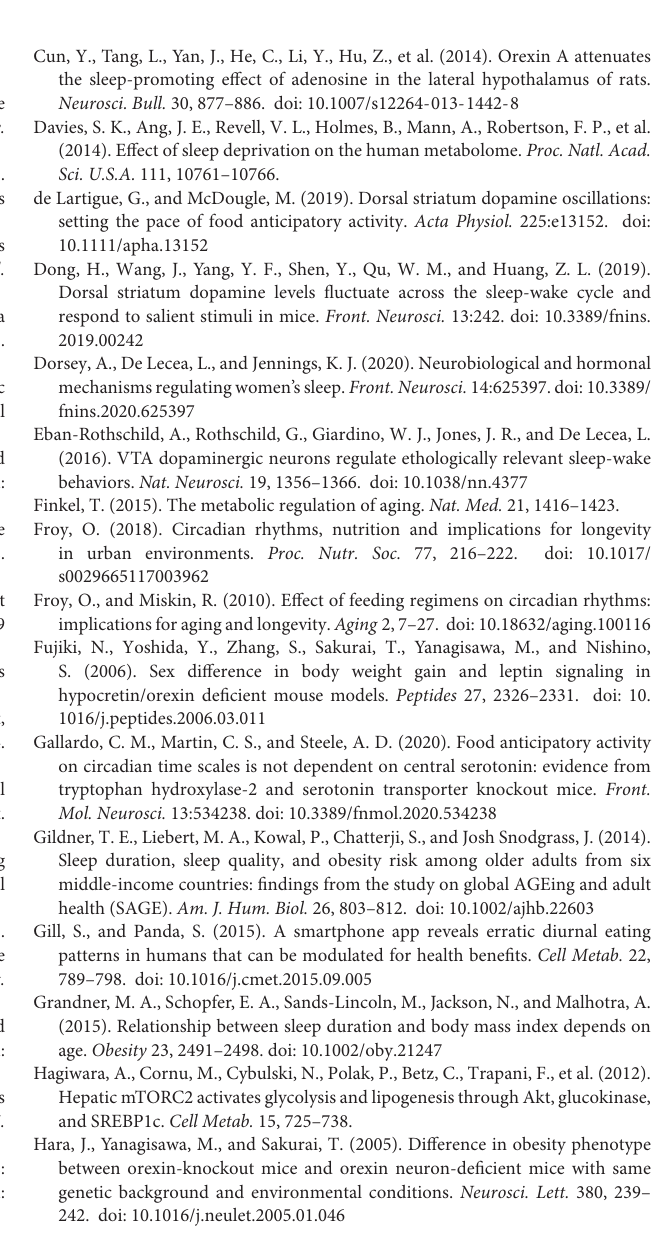
REM sleep (A) , and number/type of episode during each stage (B) during the 10 h of the light period (08:00–18:00). (C) Transitions between stages during the 10 h of the light period, n = 6. CTRL, control; RF, restricted feeding; R, REM sleep; S, slow-wave sleep; W, wakefulness. Supplementary Figure 5 | Characteristics of EEG power density during wakefulness, NREM sleep, and REM sleep in the 10 h during the light period (08:00–18:00). EEG power density during wakefulness (A) , NREM sleep (B) , and REM sleep (C) in the 10 h during the light period under the baseline condition (day 0 of the RF regime), n = 6. CTRL, control; RF, restricted feeding. Supplementary Figure 6 | Characteristics of EEG power density during wakefulness, NREM sleep, and REM sleep in the 10 h during the light period (08:00–18:00). EEG power density during wakefulness (A) , NREM sleep (B) , and REM sleep (C) in the 10 h during the light period on day 14 of the RF regime, n = 6. CTRL, control; RF, restricted